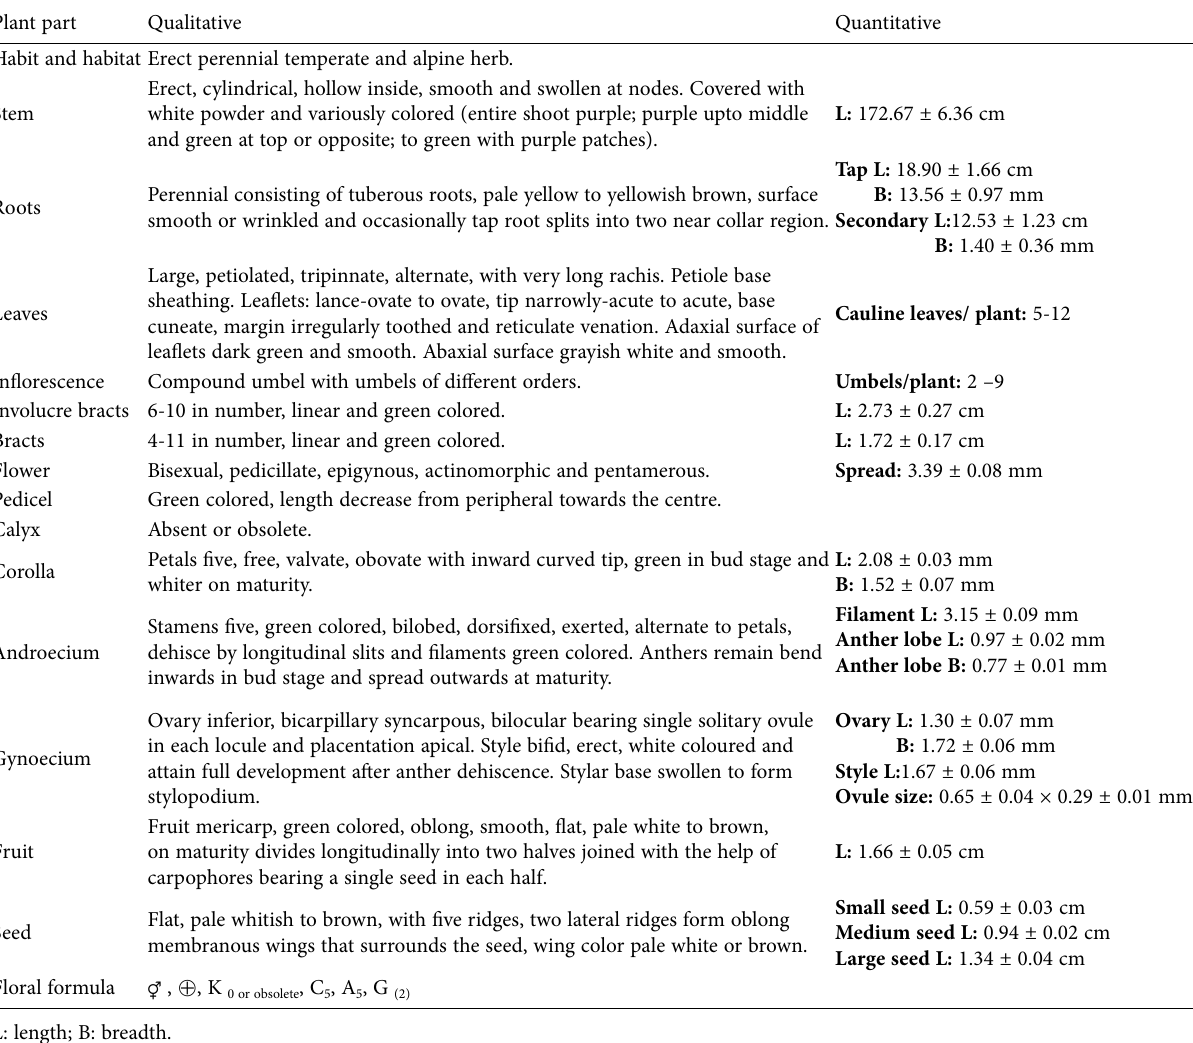
Breeding system Floral visitors like bees, flies, beetles, butterflies and ants were observed visiting its flowers. Open pollina- tion resulted in 670.27 ± 65.24 seeds/primary umbel and under autogamous conditions, only 21.82 ± 15.36 seeds/ primary umbel were set (Table 4). Based on the aver- age number of flowers per primary umbels (591 ± 38.96) with two ovules per flower, 56.71 ± 5.52% seed set under open pollination conditions and 2.63 ± 1.82% under autogamous conditions was observed. Out of is 56.71 ± 5.52% seed set under open conditions, after micro- scopic examinations, 27.49 ± 2.67% of such seeds was with embryo with the rest (29.22 ± 2.84%) being with-